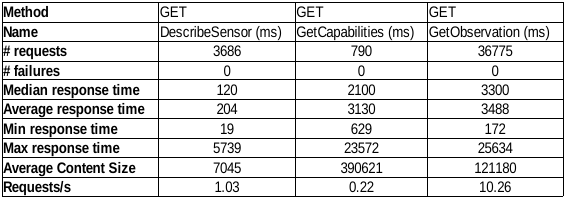
Table 2. VM-0 test results with 100 users.